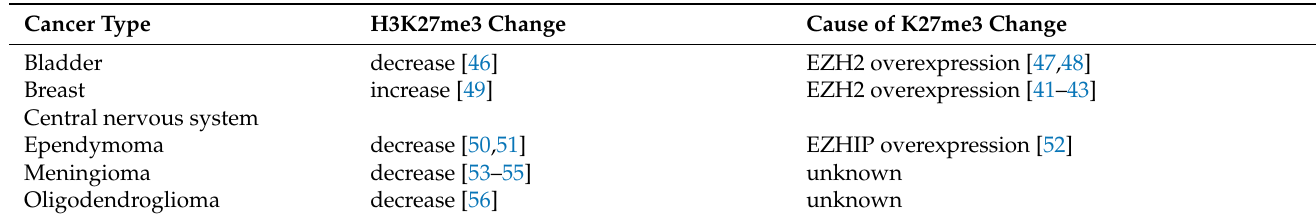
Table 1. List of cancer types with reported changes in H3K27me3